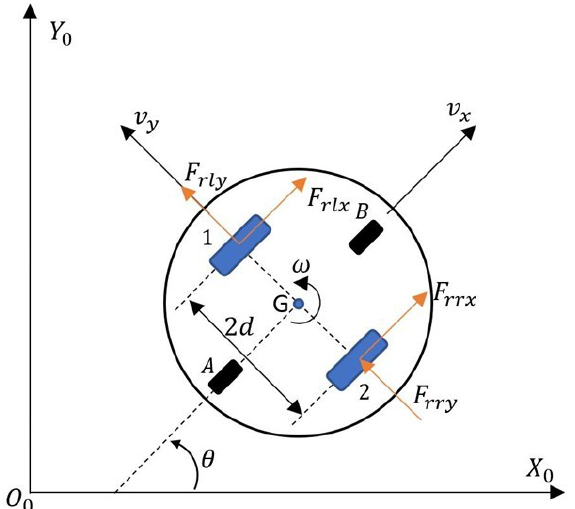
Figure 3. TURTLEBOT 2 robot schematic for developing the dynamics